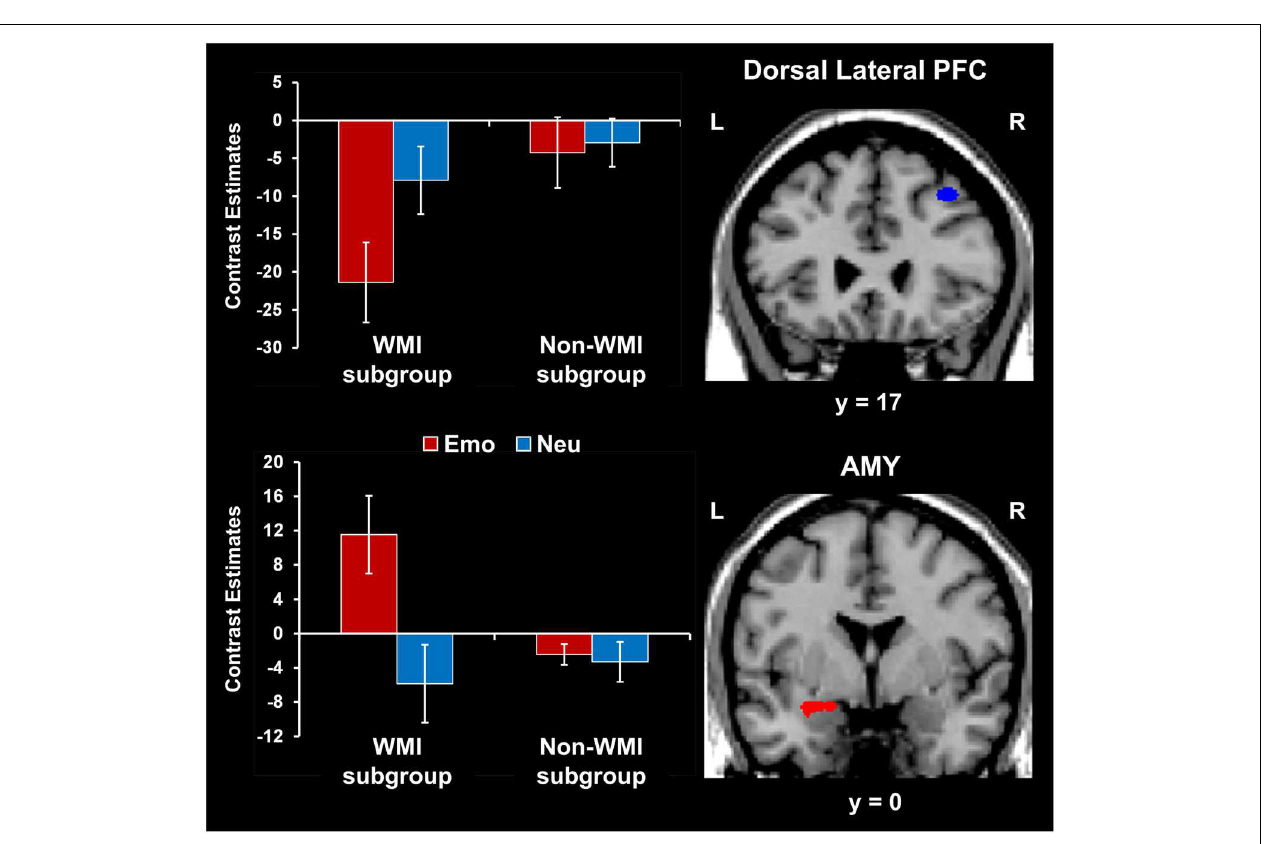
PFC (Talairach coordinates: x = 36, y = 17, z = 46), for the two subgroups. The activation maps are superimposed on a high-resolution brain image displayed in coronal view * ( y indicates theTalairach coordinate on the anterior-posterior axis of the brain). * Three voxels overlapping with the mask were identified in the dorsal lateral PFC at this location. AMY, amygdala; PFC, prefrontal cortex; Error bars represent standard errors of